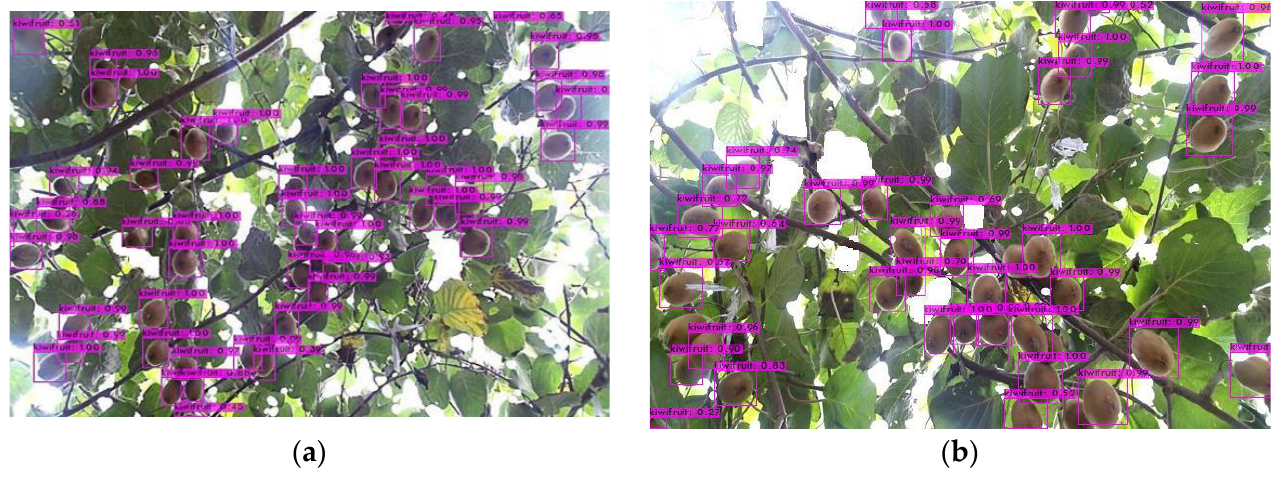
Figure 12. Double-arm picking robot fruit planning test. ( a ) Scenario 1 recognition results. ( b ) Scenario 2 recognition results.